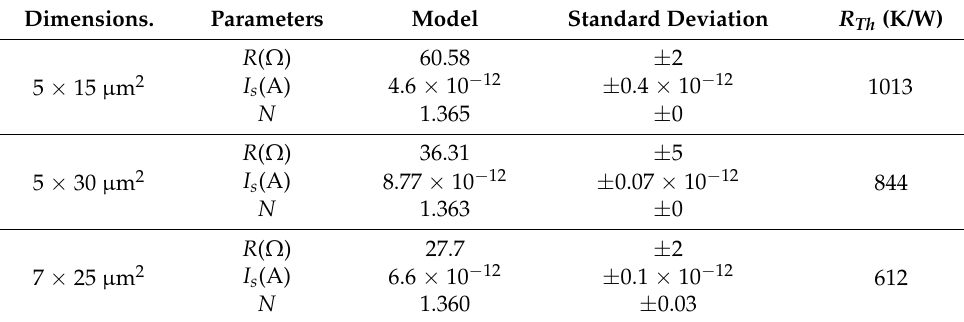
Table 3. Thermal parameter values according to the UTC-PD dimensions.